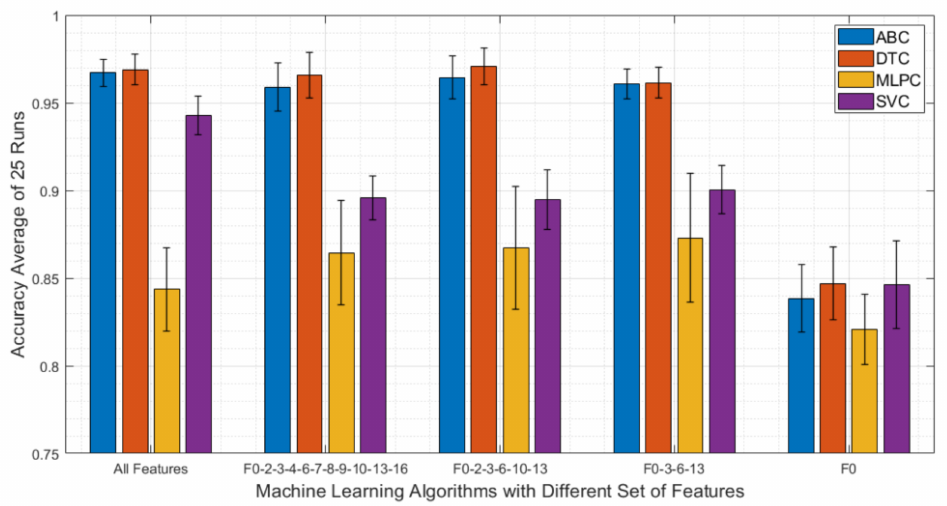
Figure 7. Machine learning algorithm result comparison for different sets of features of ABC, DTC,